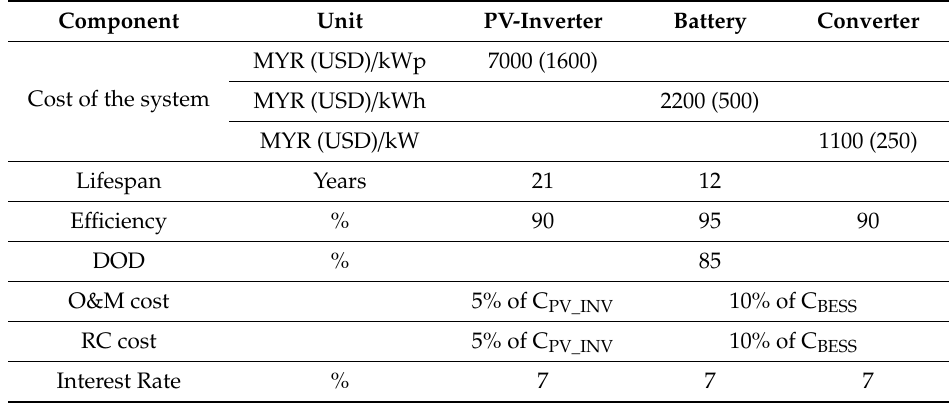
Table 8. Detail of the